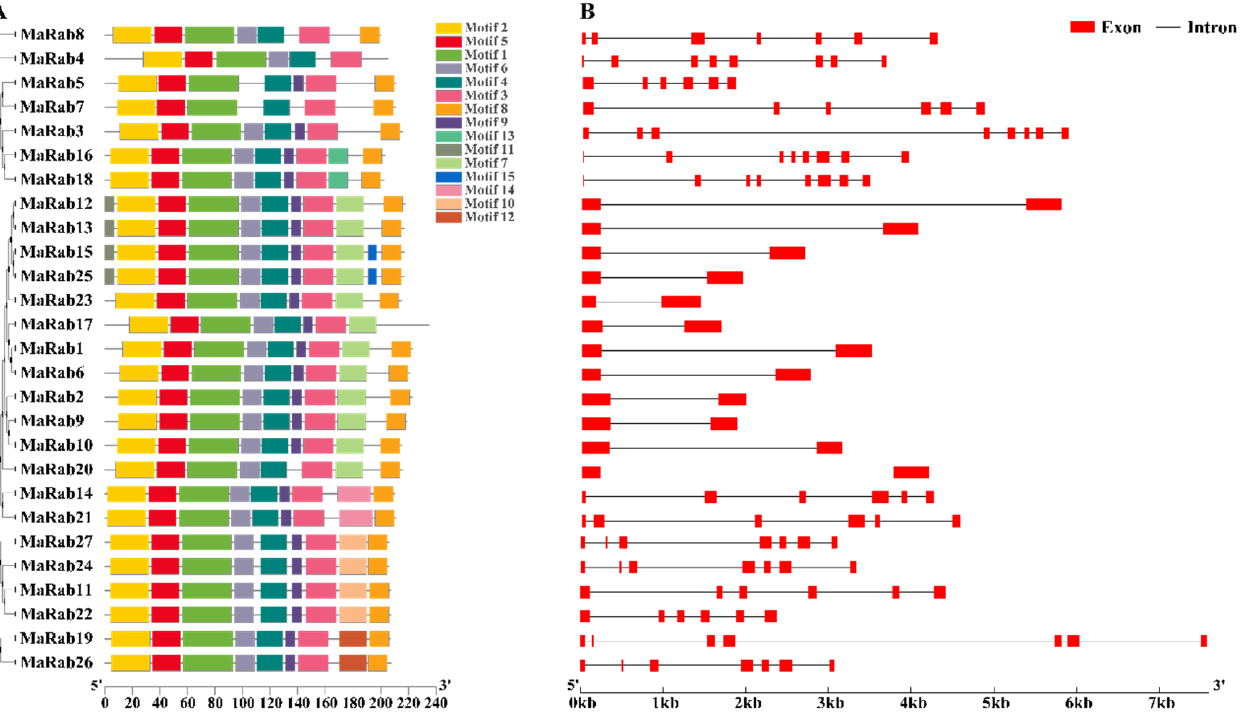
Figure 3. Distribution of conserved motifs and intron–exon structure of MaRab genes in M. albus : ( A ) Illustration of the conserved structural-domains in MaRab proteins. Different colors represent different kinds of conserved structural-domains. The nonconserved sequences are represented by the black lines. It displays 15 conserved domains and their associated motifs in the Rab protein sequences. ( B ) MaRab gene exon–intron structures. A black line designates the intron, while red boxes designate the CDS exon. At the bottom, a length scale for genes and proteins is displayed.